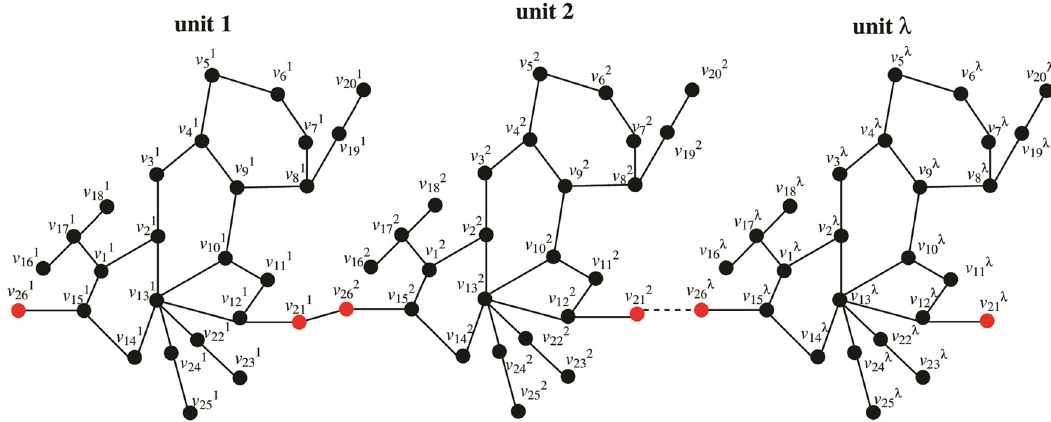
Figure 2: Supramolecular chain of complex -